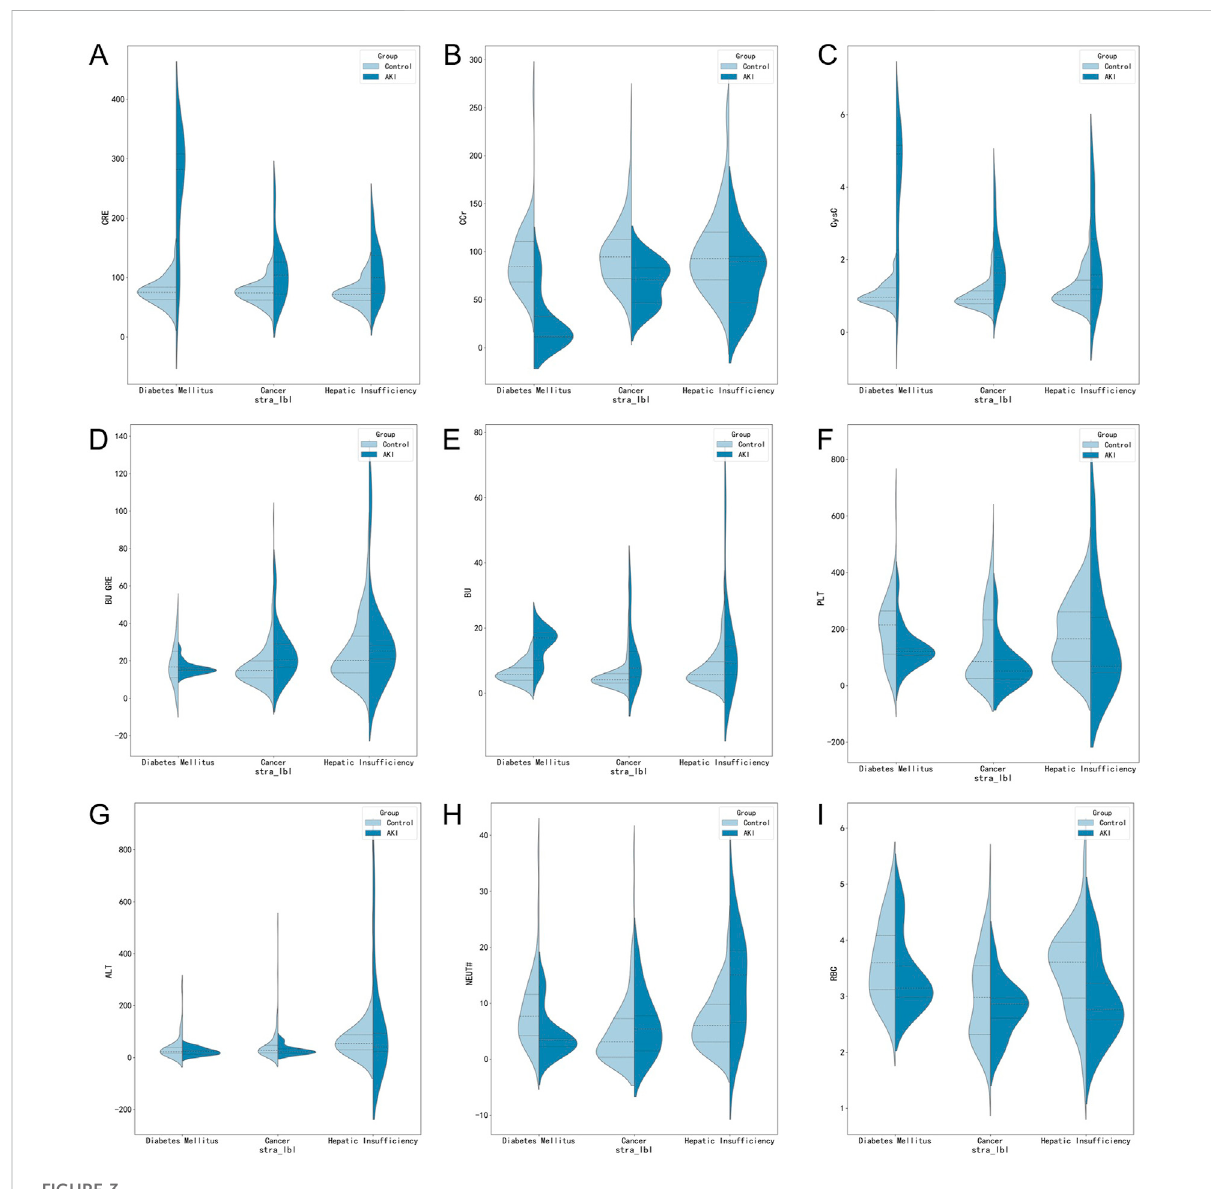
FIGURE 3 Violin plot for strati fi ed analysis in different underlying